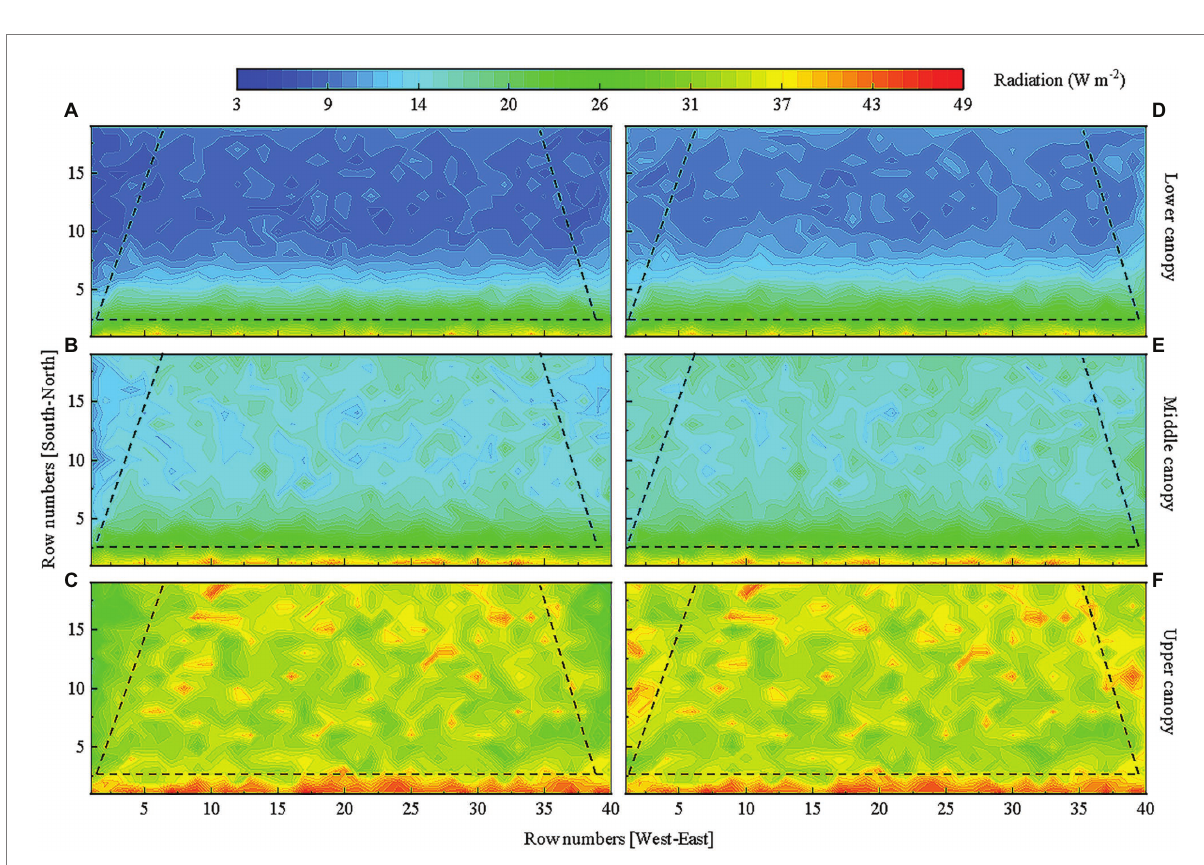
FIGURE 13 Comparison of the vertical light distribution. The simulated light distribution in the (A) lower, (B) middle, and (C) upper layers of tomato canopy without reflective films. The simulated light distribution in the (D) lower, (E) middle, and (F) upper layers of tomato canopy under final reflective film configuration scheme. Tomato canopy light interception in different areas of the greenhouse is separated by dashed lines for